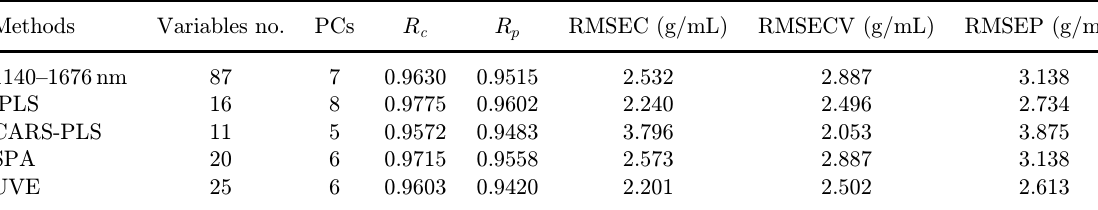
Table 6. Results of di®erent spectral regions by various variable selection methods.